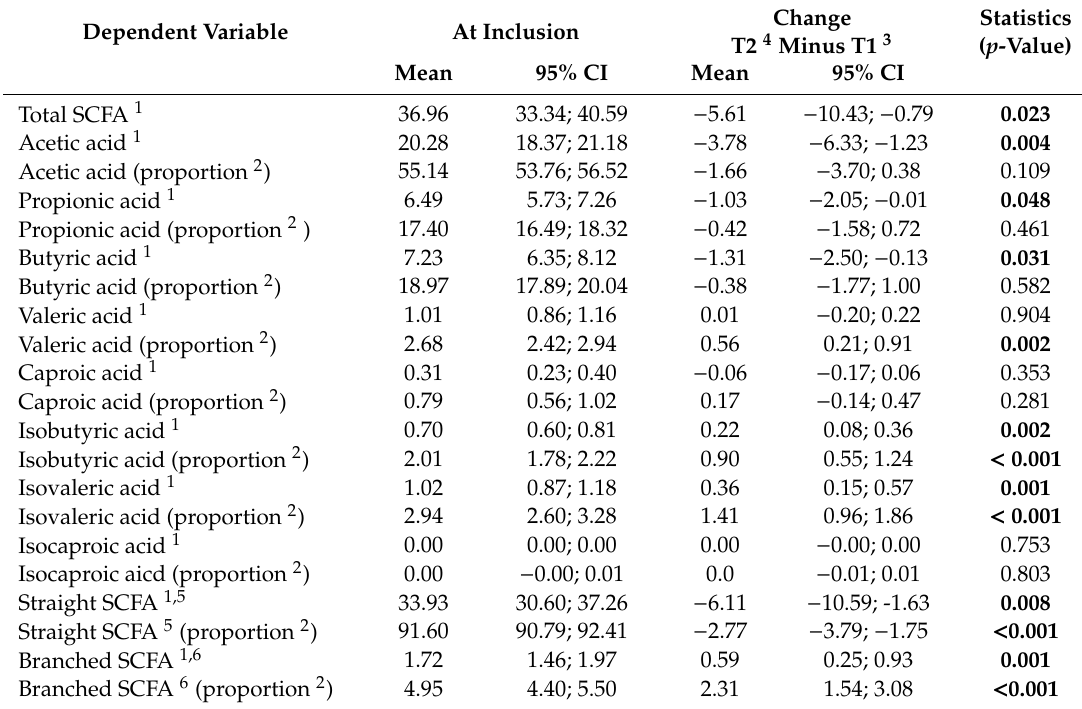
Table 1. The total and relative amounts of short-chain fatty acids (SCFA) at inclusion and changes after the weight-loss interventions. Analyzed with mixed model adjusted for point of time and the means of age and